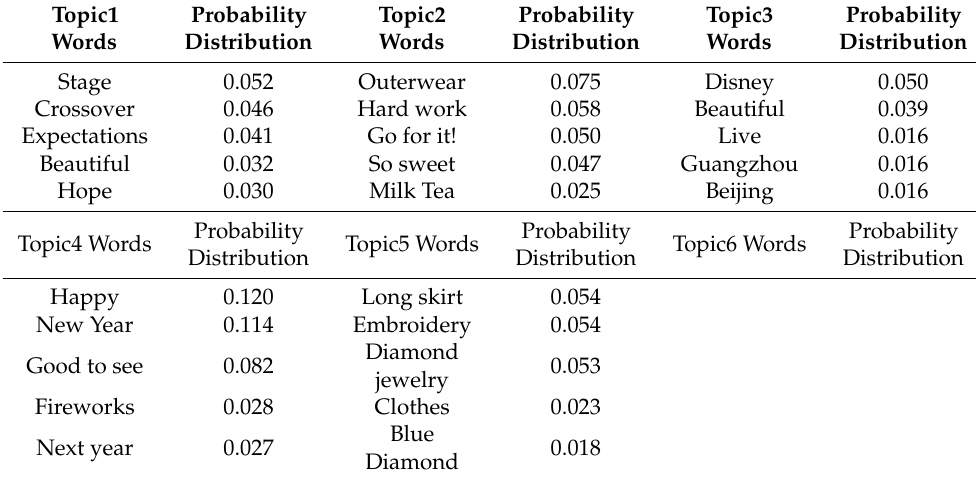
Table 12. A4 LDA theme model results.